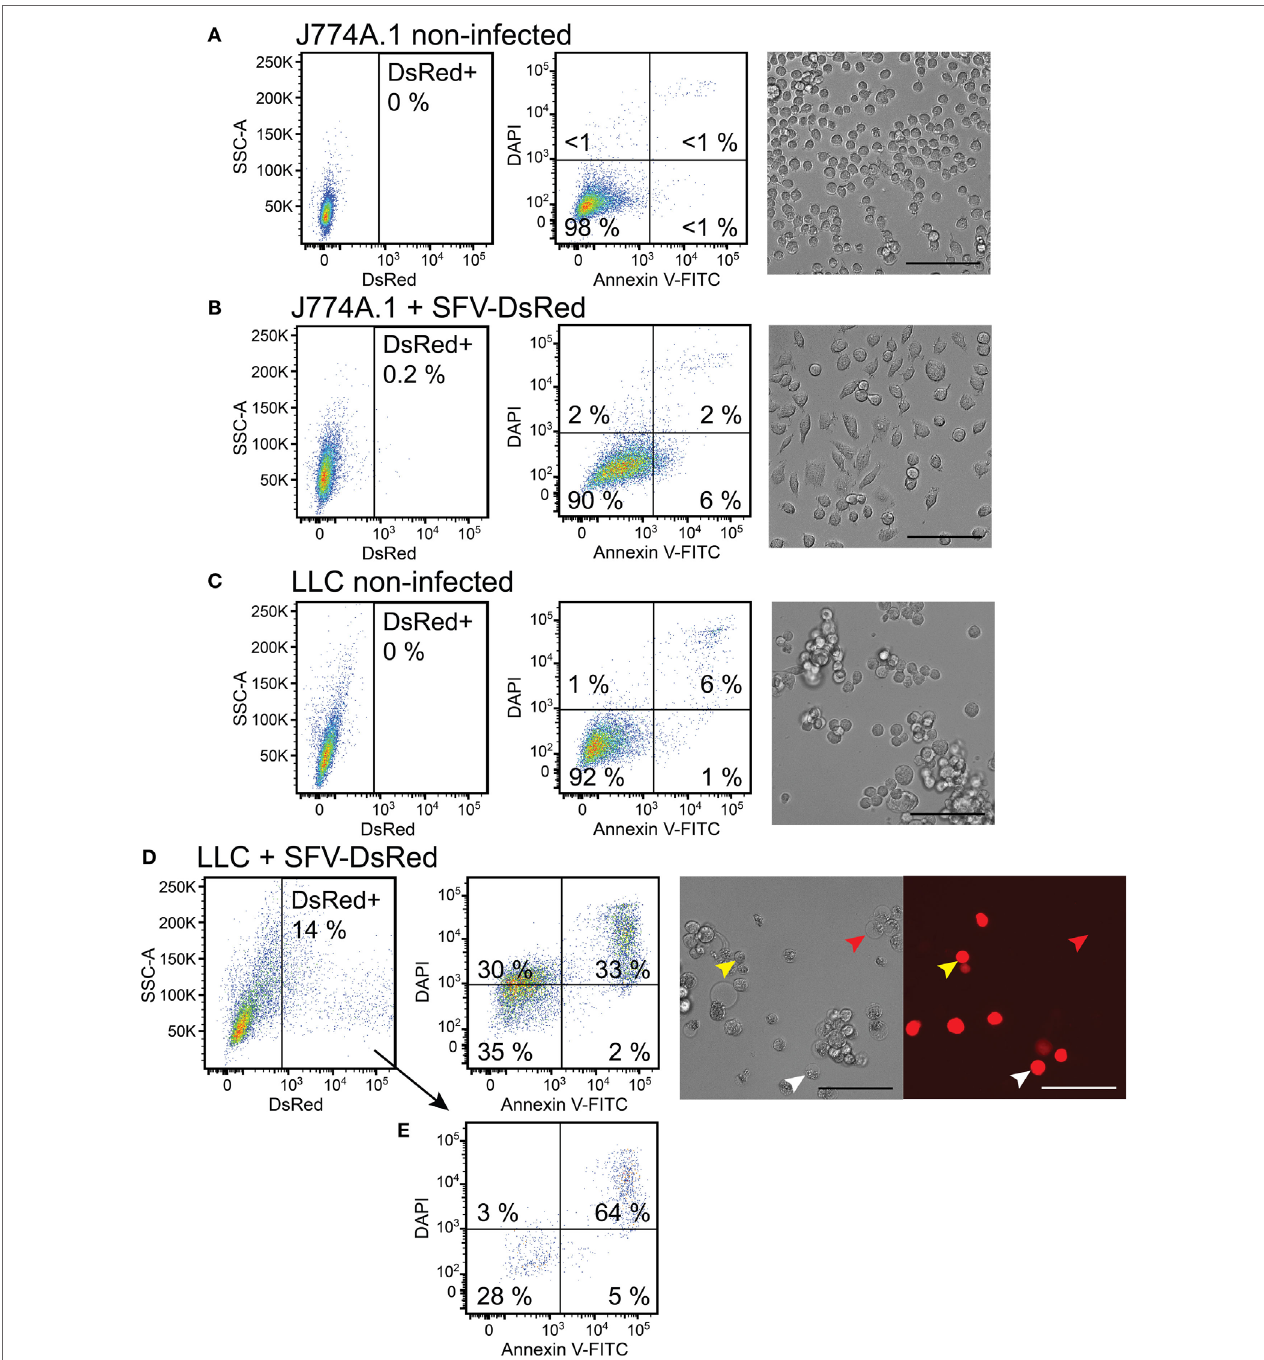
FigUre 4 | Macrophages remain viable, whereas cancer cells undergo cell death after challenge with Semliki Forest virus (SFV). J774A.1 mouse macrophages and Lewis lung carcinoma (LLC) carcinoma cells were infected with SFV-DsRed particles at MOI = 10 [determined using baby hamster kidney (BHK-21) cells]. DsRed expression (first column, x -axis) was evaluated at 48 h post-infection using flow cytometry and fluorescence microscopy (scale bar 100 µM). Cell morphology was observed using bright-field microscopy (scale bar 100 µM) and cell death was quantified 48 h post-infection using flow cytometry analysis after cell staining with annexin V-FITC (second column, x -axis) and DAPI (second column, y -axis). Annexin V-positive/DAPI-negative cells were regarded as early apoptotic, whereas annexin V-positive/PI-positive cells were regarded as late apoptotic and necrotic. (a) Non-infected J774A.1 macrophages were used as a negative control. (B) J774A.1 macrophages were resistant to SFV infection, stayed viable but changed their morphology 48 h after challenge with SFV. (c) Non-infected LLC cells were used as a negative control. (D) LLC cells were susceptible to SFV infection and underwent cell death. DsRed expression was observed using microscopy in both apoptotic (white arrows) and viable (yellow arrows) cells, whereas some apoptotic cells lacked DsRed expression (red arrows). (e) The infected DsRed-positive cells were both viable and undergoing cell death. The average of duplicates with SEM < 10% from one experiment is shown.